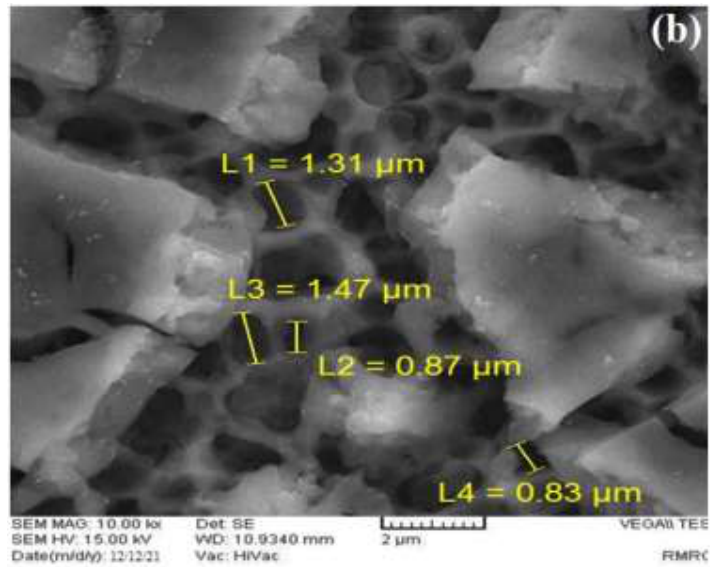
Figure 4: (a) SEM micro-image of macPSi substrate, and (b) magnified micro-image.